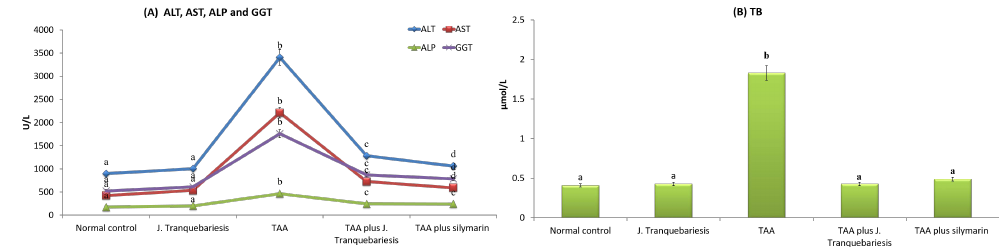
Figure 3. ( A , B ) Effects of Justicia tranquebariesis L. on hepatic markers and TB in TAA intoxicated rats. Values are expressed as mean ± S.D. for six animals in each group. Values not sharing a common superscript (a–d) differ significantly. Letter “a” is significant to b, c, and d; likewise a letter “b” is significant to a, c, and d. TB—total bilirubin; ALT—alanine aminotransferase; AST—aspartate aminotransferase; ALP—alkaline phosphatase;